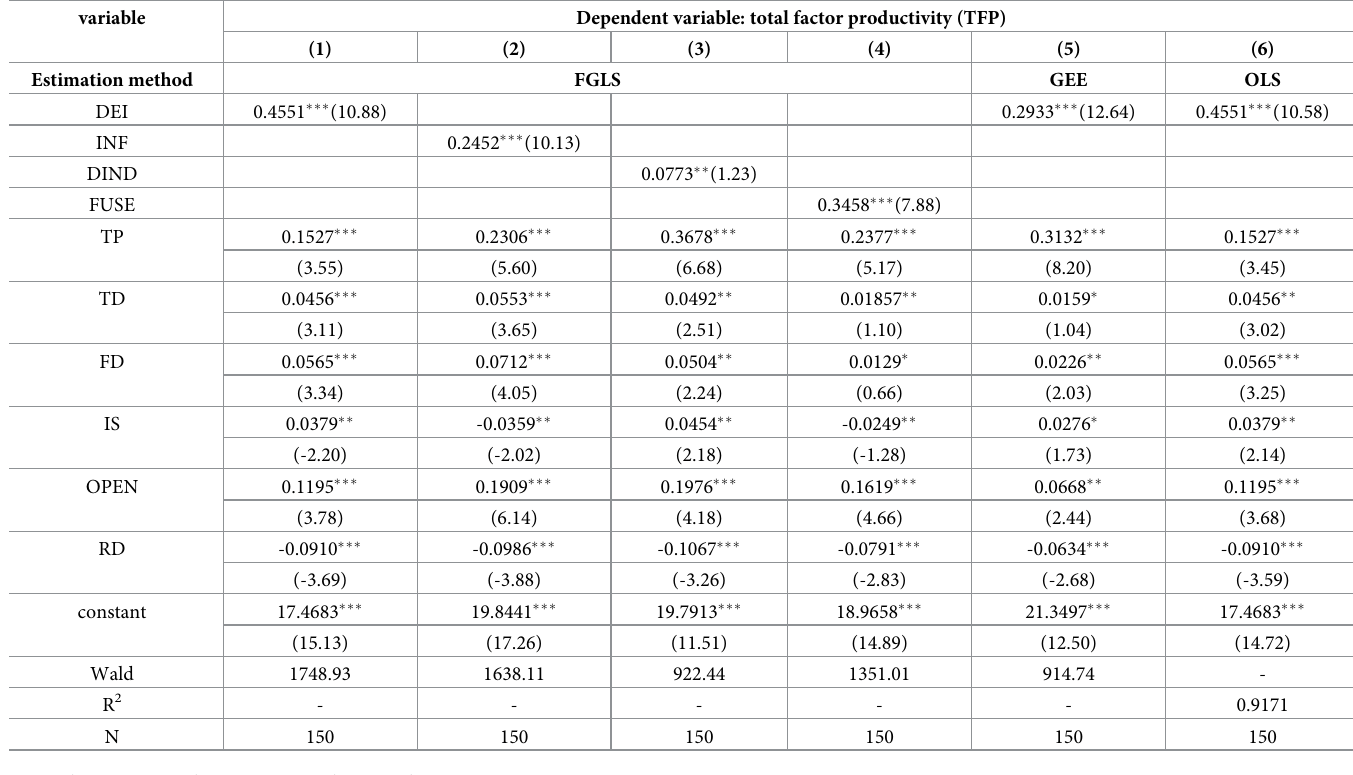
Table 6. The regression results of the digital economy index and its infrastructure sub-index, industry sub-index, and integration sub-index.